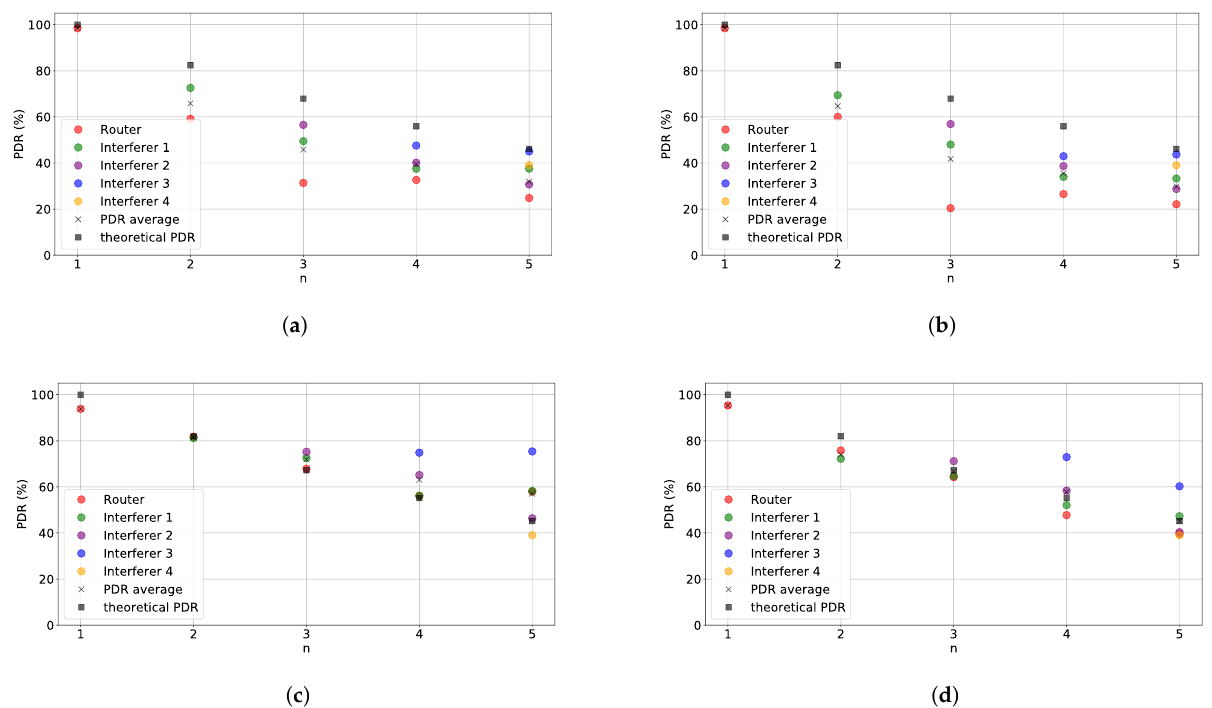
Figure 4. Performance evaluation results. Percentage of Acknowledgments (ACKs) received per packet transmitted vs number of nodes in the network for different configurations: ( a ) SF = 7, P tx = 0 dBm, ( b ) SF = 7, P tx = 14 dBm, ( c ) SF = 12, P tx = 0 dBm, and ( d ) SF = 12, P tx = 14